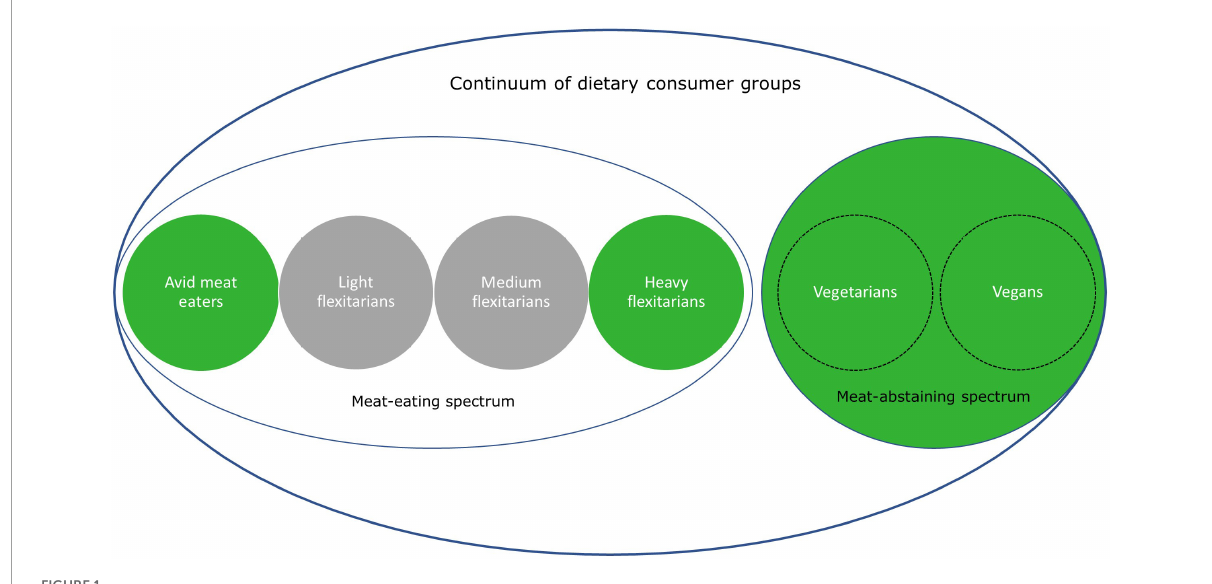
FIGURE1 Continuum of dietary consumer group (green groups are included in the